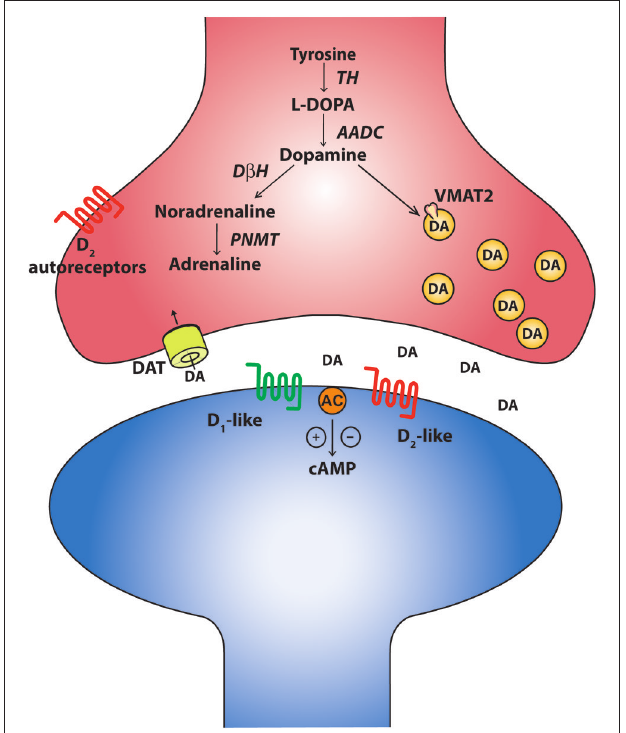
FIGURE 1 | The canonical catecholaminergic neuron is one that generates dopamine, noradrenaline or adrenaline . Catecholamines are synthesized from tyrosine through a series of biosynthetic steps progressing from tyrosine hydroxylase (TH) producing L-DOPA, aromatic amino acid decarboxylase (AADC) producing dopamine, dopamine- β -hydroxylase (DBH) producing noradrenaline and phenylethanolamine-N-methyl-transferase (PNMT) producing adrenaline. These neurons also express the vesicular monoaminergic transporter (VMAT2) to pump catecholamines into synaptic vesicles. A canonical dopaminergic neuron will also express dopamine reuptake transporters (DAT) and inhibitory D 2 autoreceptors to regulate presynaptic release of dopamine. Post synaptic targets of dopamine include the excitatory D 1 -like and inhibitory D 2 -like receptors that act through G-protein second messenger cascades, increasing and decreasing intracellular cAMP levels